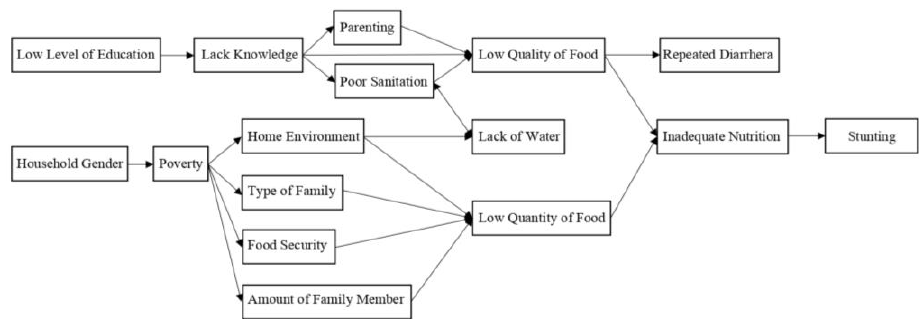
Figure 2. Family Household Characteristics and Stunting.